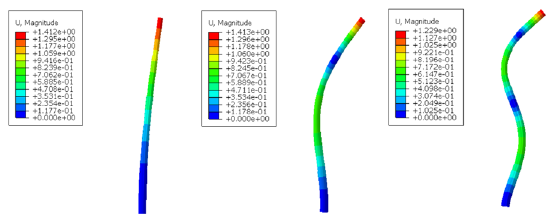
Figure 9 Modal shape of segmented model of TTM